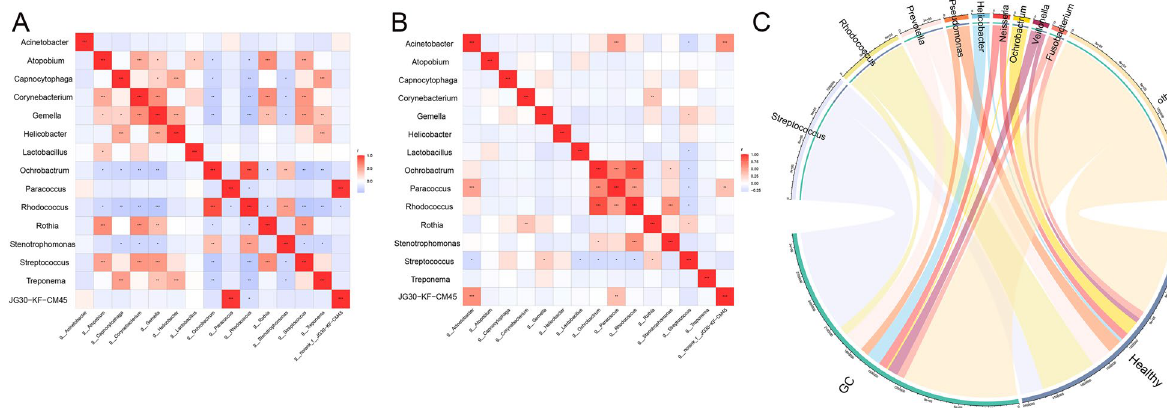
Fig. 3 Correlation analysis of different bacteria within and between groups. The numerical matrix of the two groups of different bacteria is visually displayed through the heatmap. The color change reflects the data information, and the color depth represents the correlation. The redder the color is, the higher the correlation between the two bacteria. A Intragroup bacterial correlation heatmap of the healthy group. The Pearson coefficient was used to calculate the correlation between the bacteria. The shade of color indicates the size of the data value. Pearson correlation coefficients are indicated in the figure. *0.01 < p < 0.05; **0.001 < p ≤ 0.01; ***p ≤ 0.001. B Intragroup bacterial correlation heatmap of the GC group. C Chord diagram. One side of the circle is the species name, and the other side is the sample name, which is rep- resented by different colors. The species abundance is displayed as a